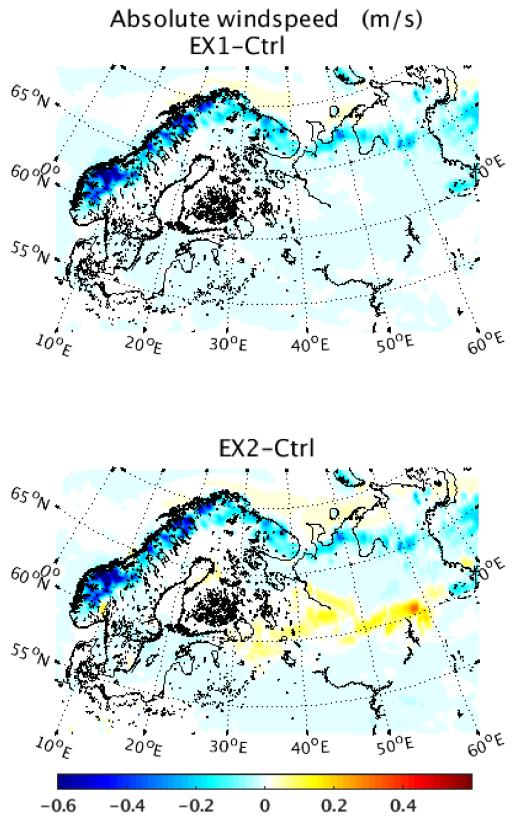
Figure 5. Changes in 10-year average absolute wind speed (ms − 1 ) for Ex 1 (upper panel) and Ex 2 (lower panel) as compared to the control